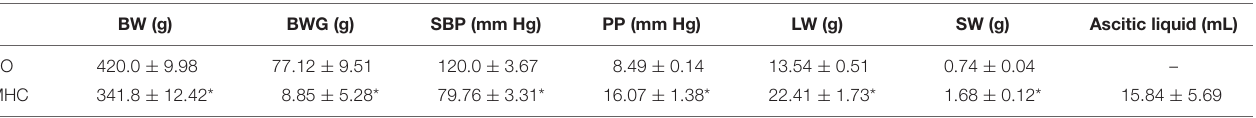
TABLE 1 | Effect of microsurgical liver cholestasis (MHC) on body weight (BW), body weight gain (BWG), systolic blood pressure (SBP), portal pressure (PP), liver weight (LW), spleen weight (SW) and ascitic liquid extravasation in Wistar rats. BW (g) BWG (g) SBP (mm Hg) PP (mm Hg) LW (g) SW (g) Ascitic liquid (mL) SO 420 . 0 ± 9 . 98 –